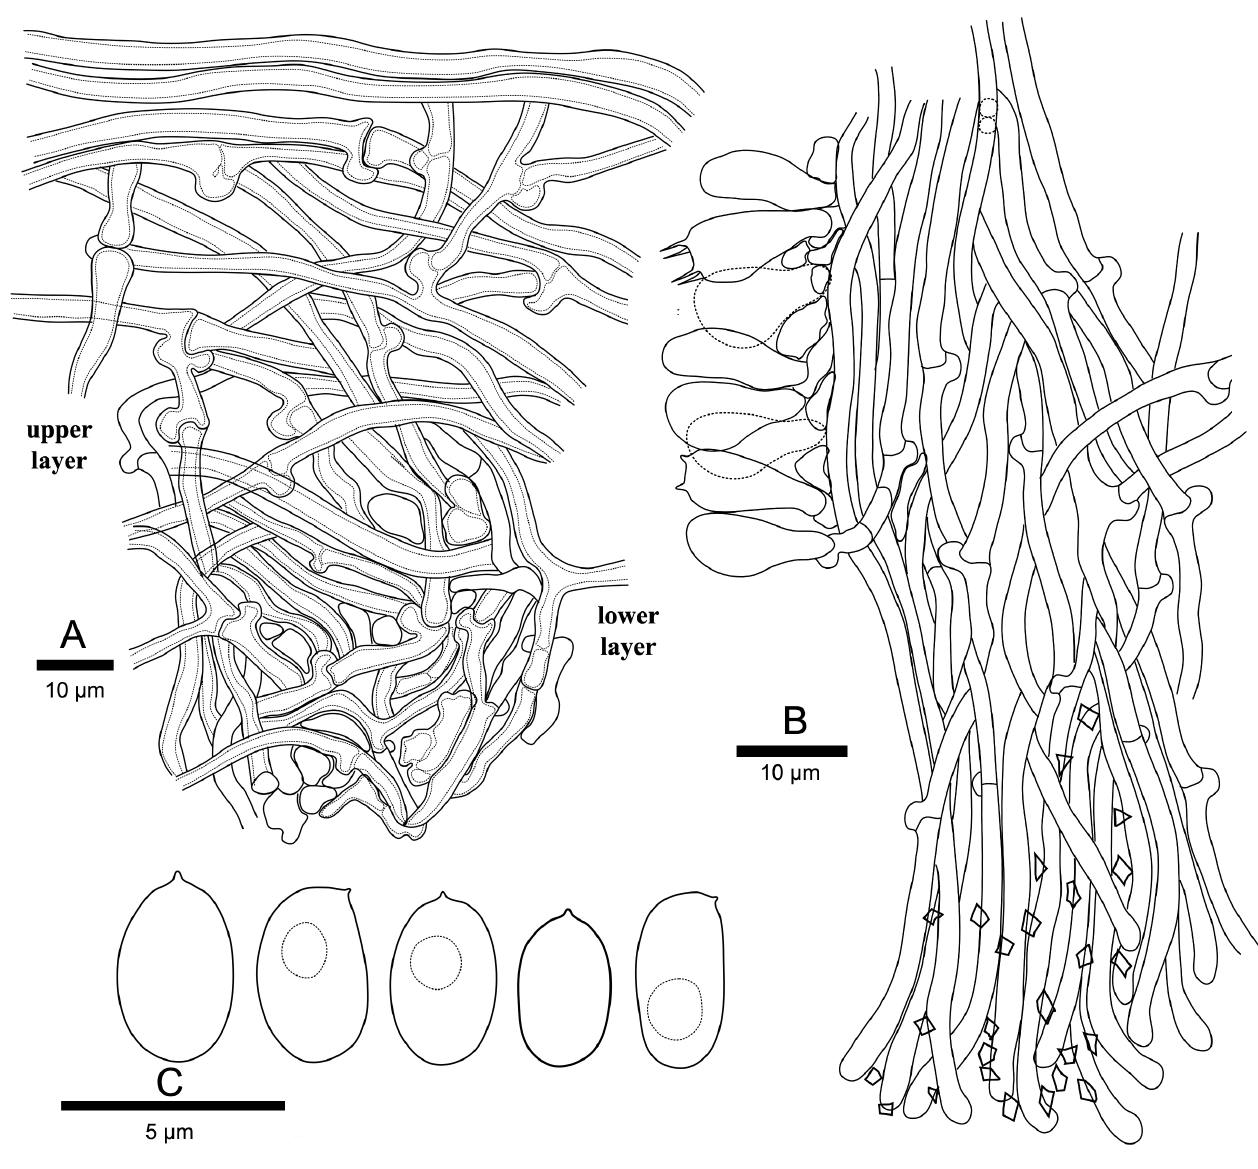
Figure 5 – Microscopic structure of Bjerkandera mikrofumosa . A . Two-layered context. B . Hymenium and tramal hyphae with rhomboid crystals. C . Basidiospores. Illustrations by V.